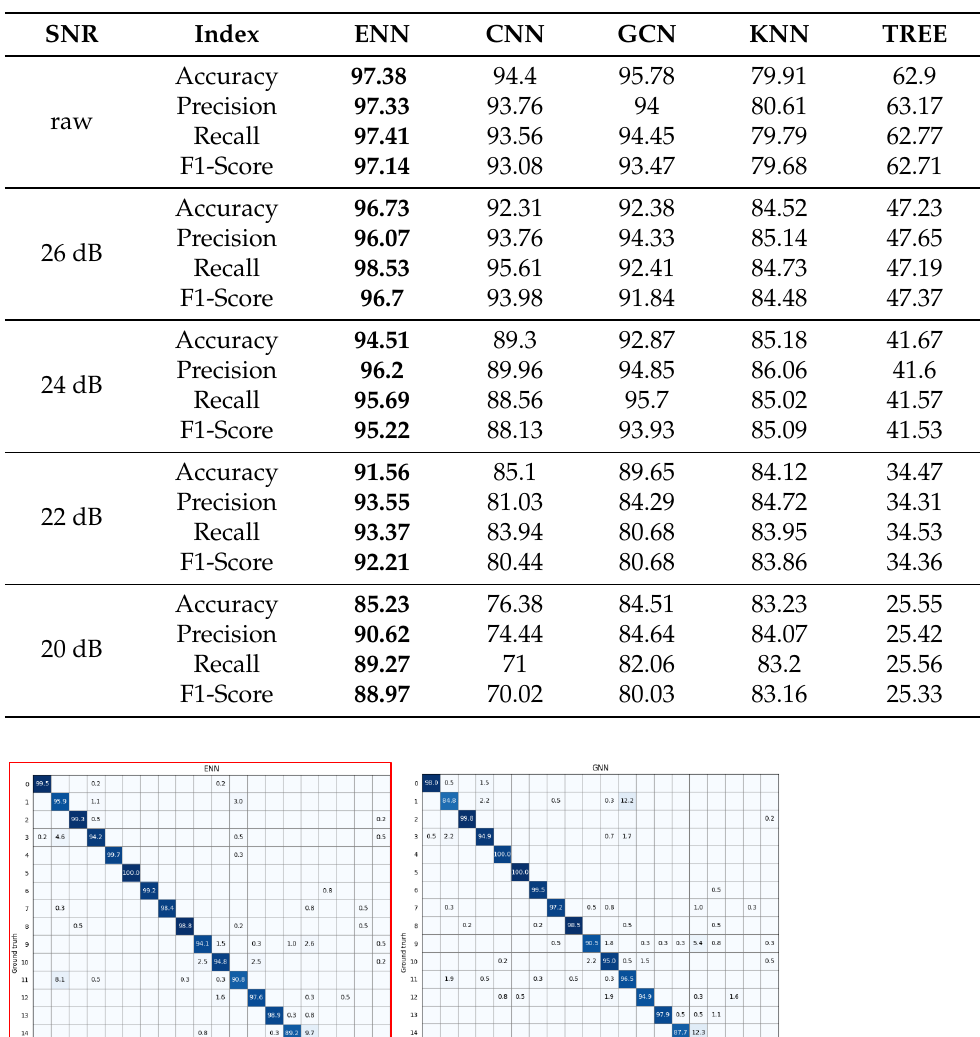
Table 2. A Summary of the evaluated indicators of different methods at various SNRs. Experimental results of our model are bolded.